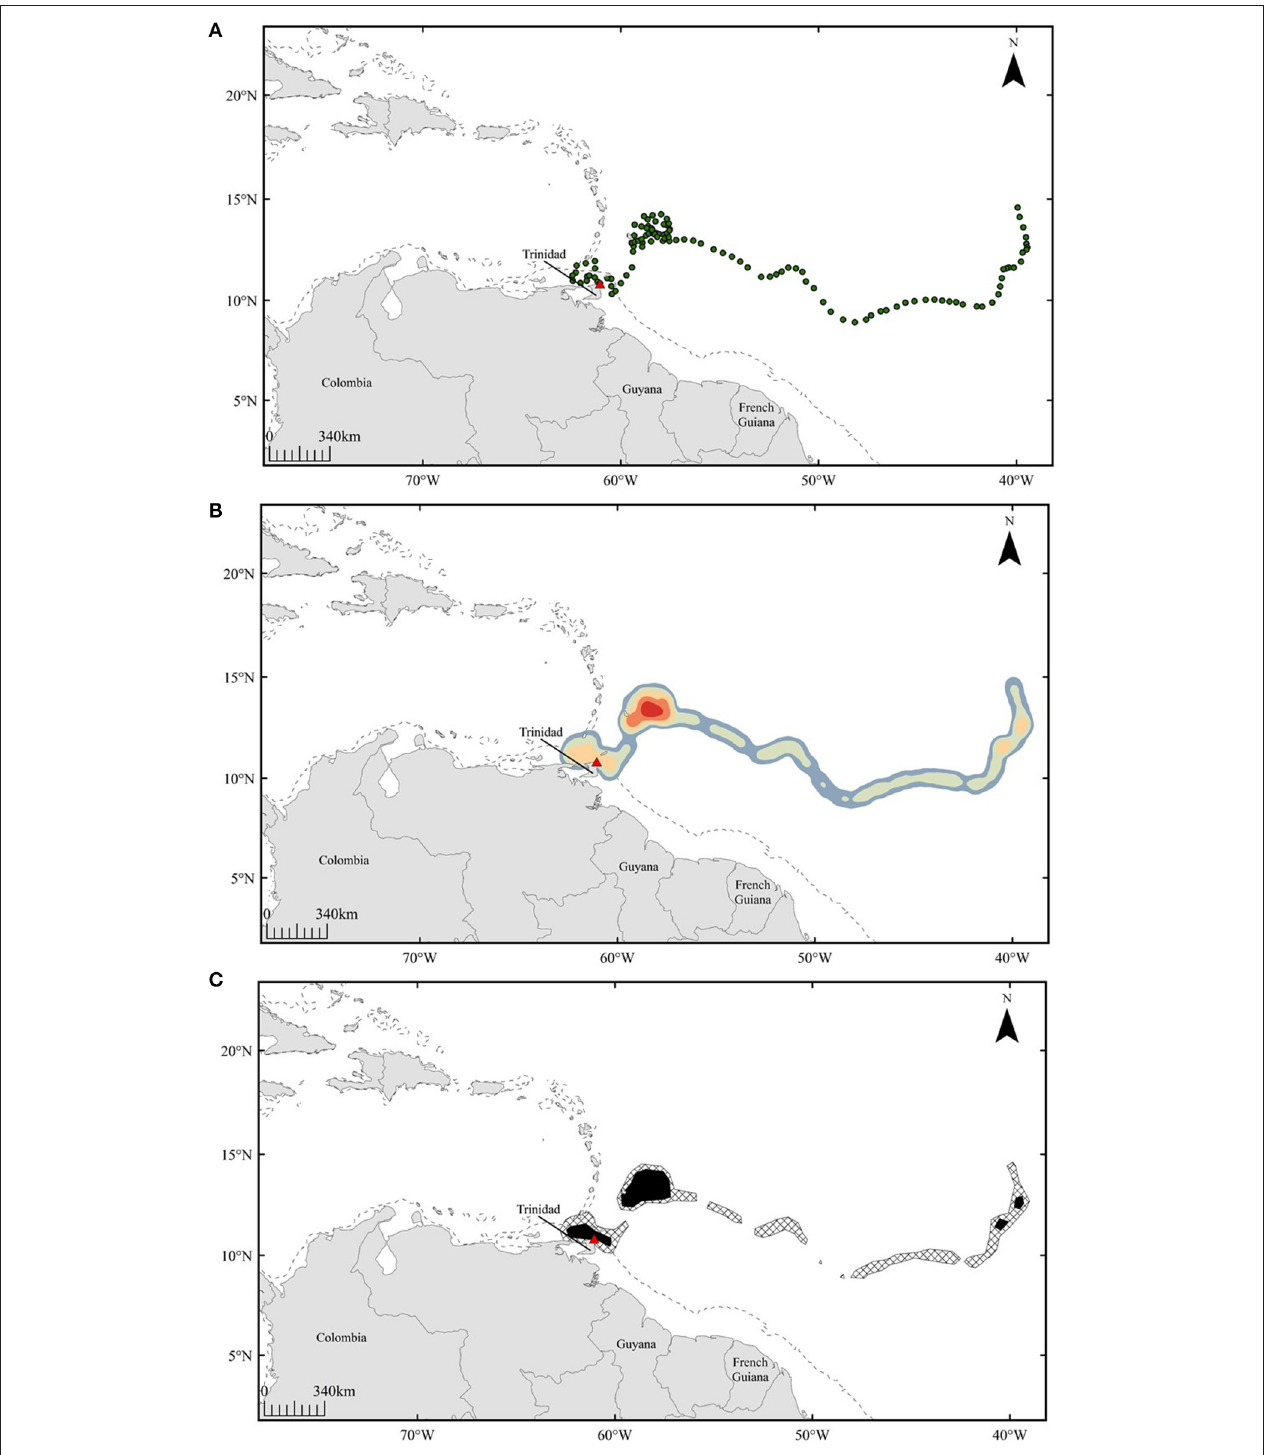
FIGURE 1 | Representative example of spatial analyses conducted for pre-nesting leatherbacks: turtle E. Panels show interpolated positions for 120 days prior to nesting (A) , heatmap displaying areas of high density (red) (B) , and 50% (black) and 95% (hatched) volume contours generated from kernel density results (C) . Dashed line represents 200m